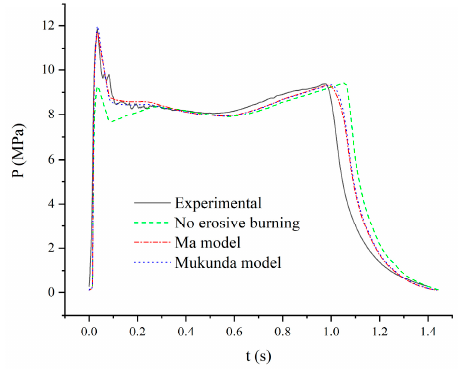
Figure 6. Pressure history results.